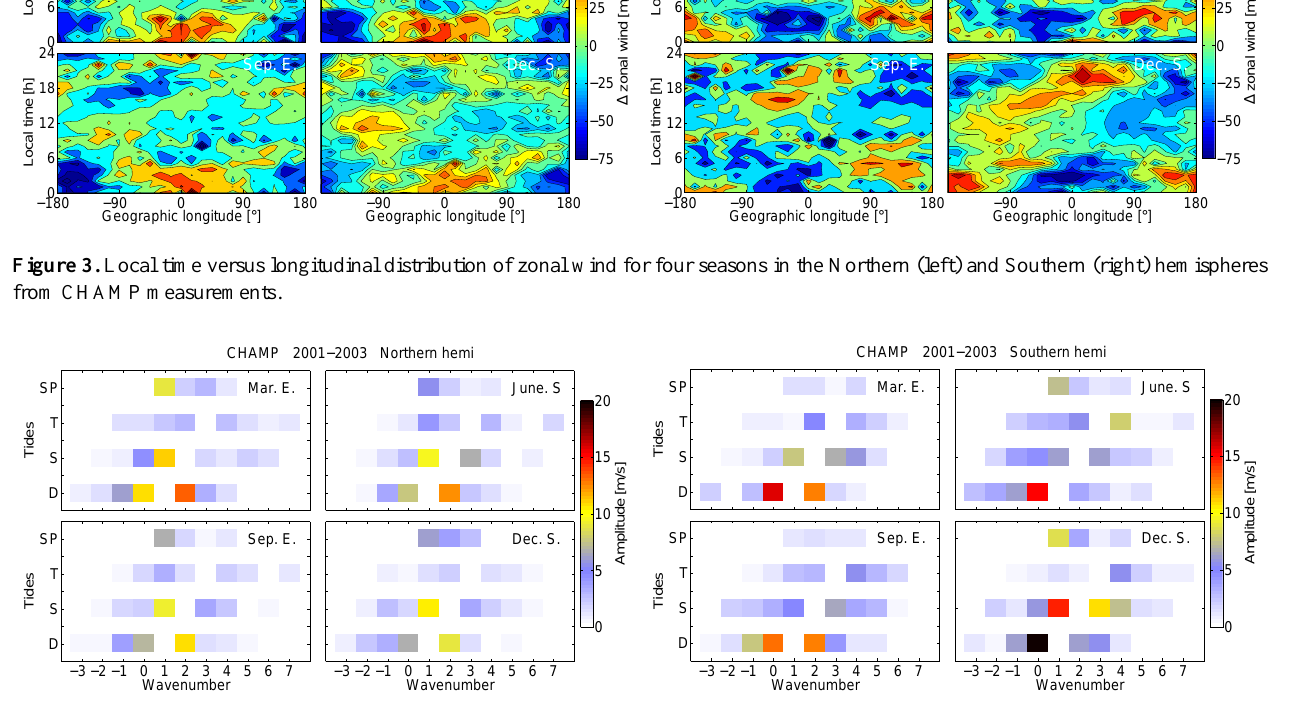
Figure 4. Spectra of the tidal and stationary components in zonal wind from the Northern (left) and Southern (right) hemispheres from CHAMP